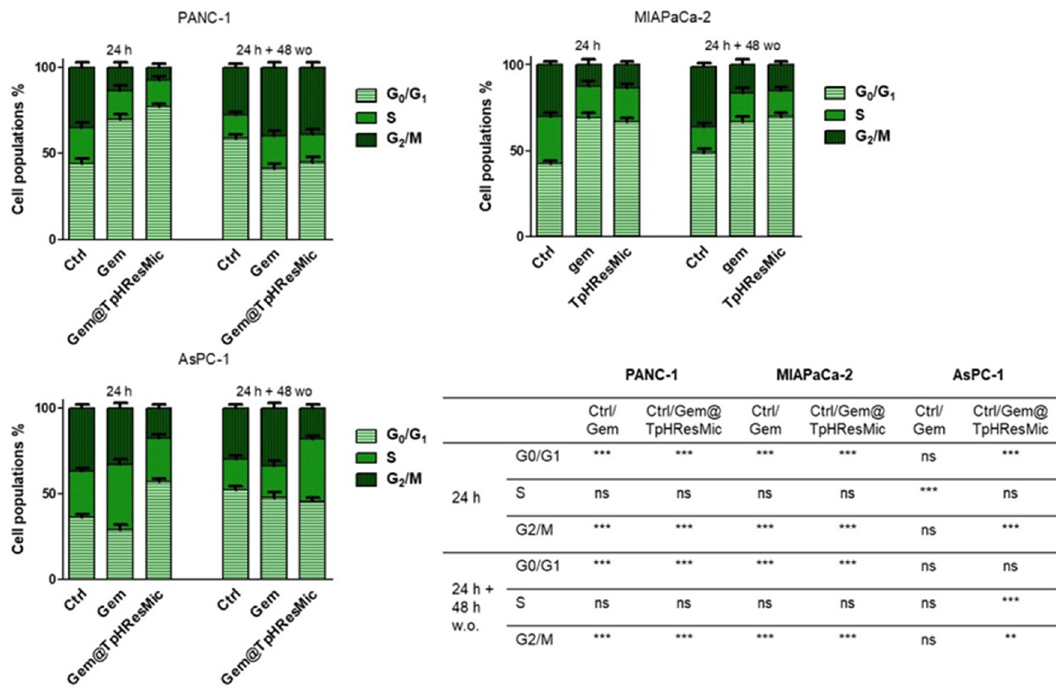
Figure 13. Cell cycle perturbation of PDAC cells by free Gem and Gem@TpHResMic at pH 6.8 after 24 h and 24 h + 48 h w.o. The modulation of cell cycle phases was evaluated by FCM analysis after staining the cells with propidium iodide. The bar graphs show % cell population distributions in G0/G1, S, or G2/M phases, reported as the mean ± SD of the three independent experiments, and the statistical significances are reported in the table (** p < 0.01, *** p < 0.001).